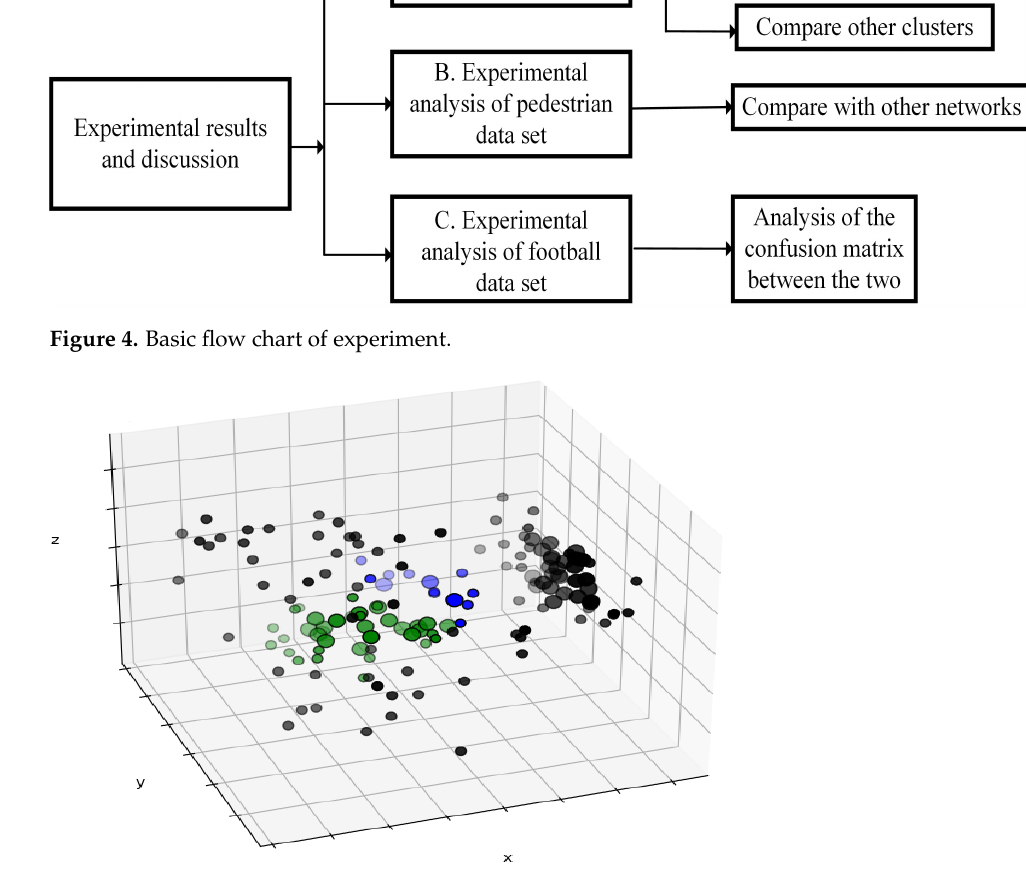
Figure 5. Data distribution of DEC potential